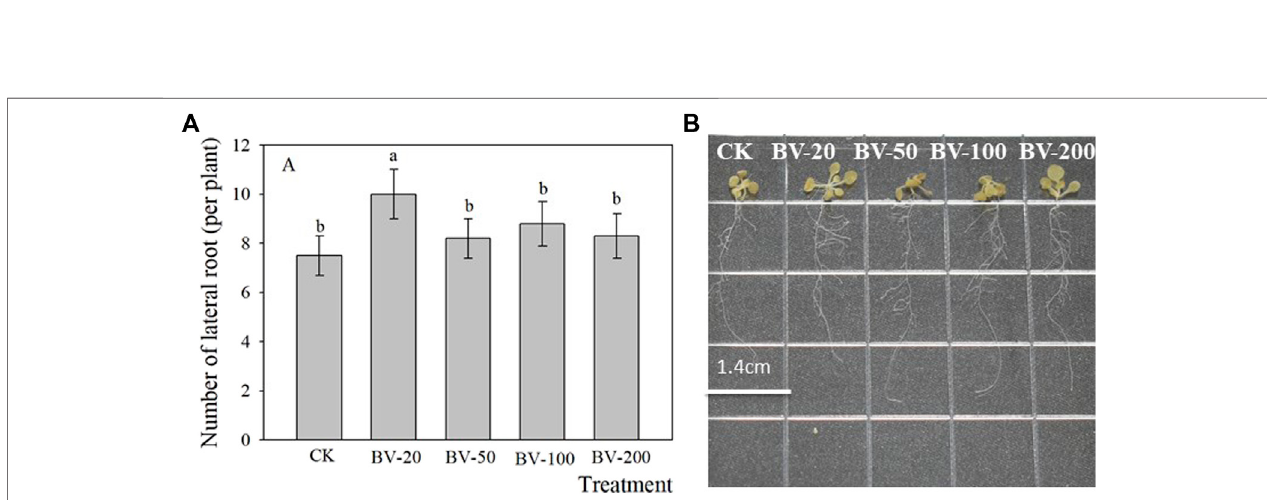
FIGURE3| Effects ofdifferentconcentrationsofBVnanomaterialsonthenumber oflateralrootsin Arabidopsis. Barof (A) wasstandarderror. CK, BV-20, BV-50, BV-100, andBV-200 of (Aand B) were addedtotheMSmedium with0, 20,50,100,and 200 μ g ml − 1 ofBV,respectively. N (cid:2) 15.Differentlowercaseletters above the bar of (A) indicate that there were signi fi cant differences among the treatments at p < 0.05.